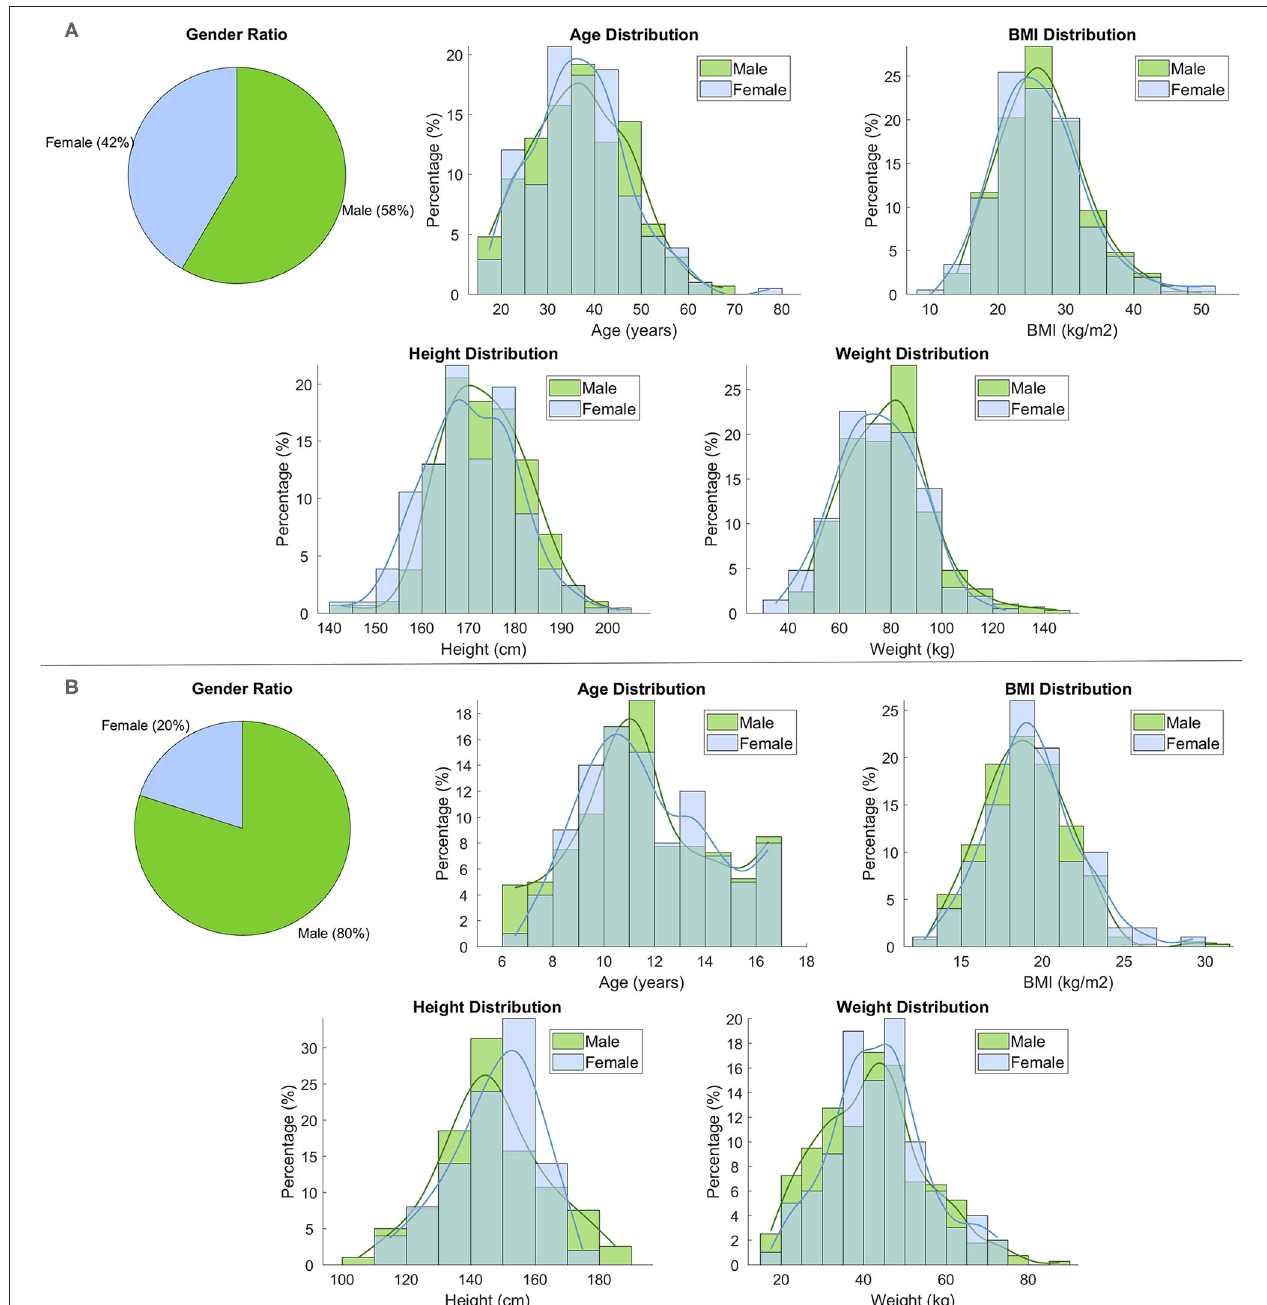
FIGURE 6 | Demographic characteristics (sex, age, BMI, height, and weight) of (A) the adult virtual population ( N = 500) and (B) the pediatric-adolescent virtual population ( N = 500).